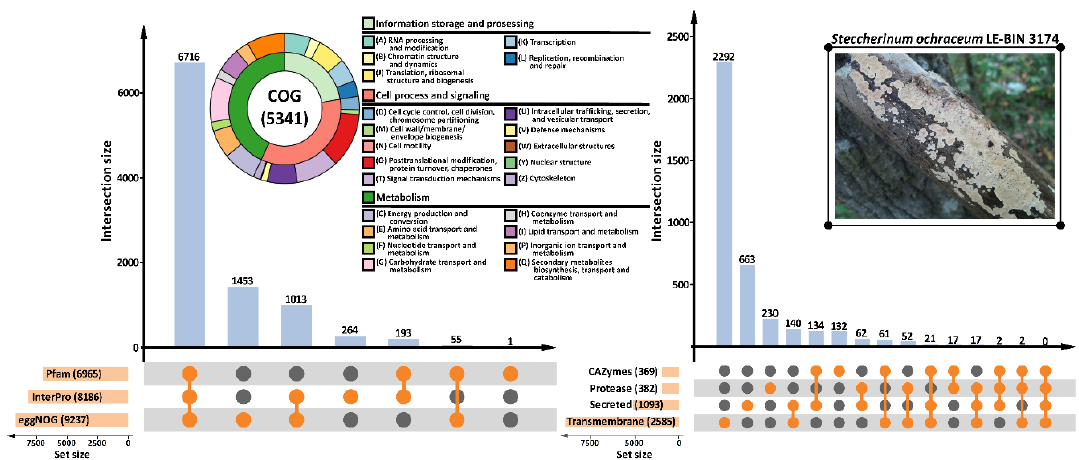
Figure 1. Functional annotation of the S. ochraceum LE-BIN 3174 genome. Number of annotations produced with different databases as well as number of gene models that received these annotations are represented with the UpSet plots [49]. Information about clusters of orthologous groups (COG) content of the genome is summarized on the double-layer donut chart. Note: CAZymes = carbohydrate-active enzymes.